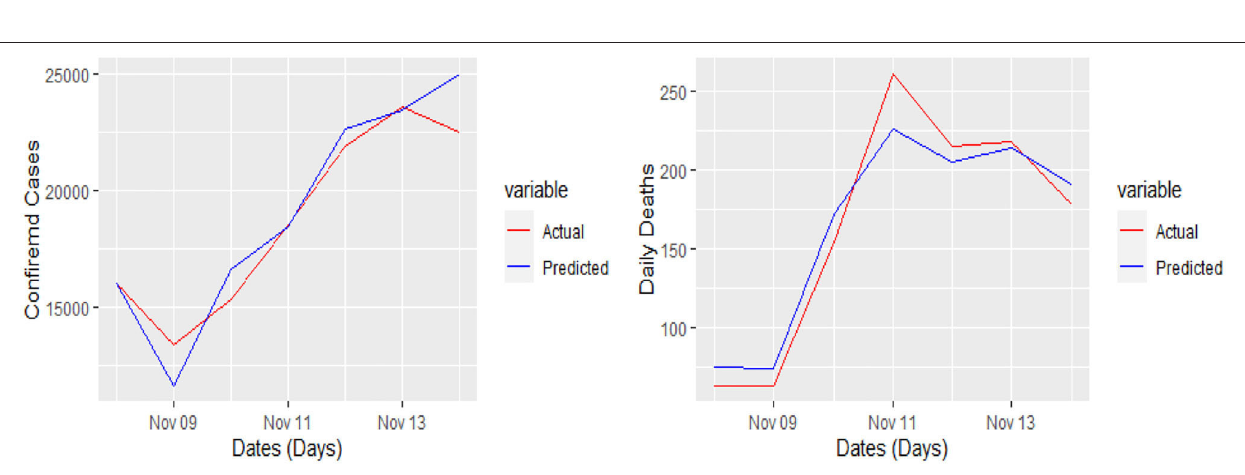
FIGURE 7 | Actual and predicted 7 days daily confirmed cases and daily deaths from COVID-19 in Germany.